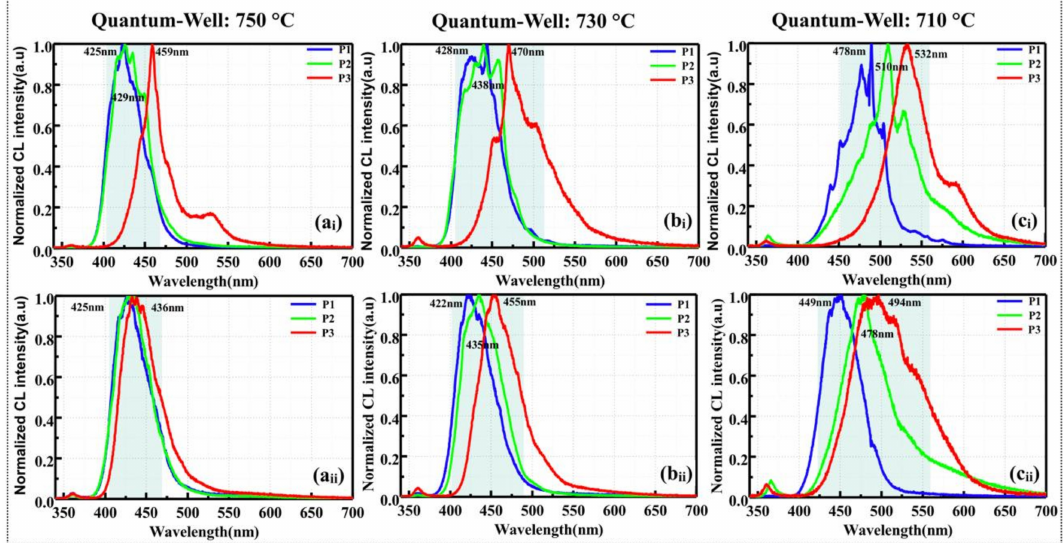
Figure 7. Normalized CL emission spectra of the top areas of the NWs in samples d, e, and f grown with di ff erent well temperatures of ( a i ) 750 ◦ C; ( b i ) 730 ◦ C; and ( c i ) 710 ◦ C, respectively. The bottom panels are the normalized CL spectra measured at the bottom areas of the corresponding